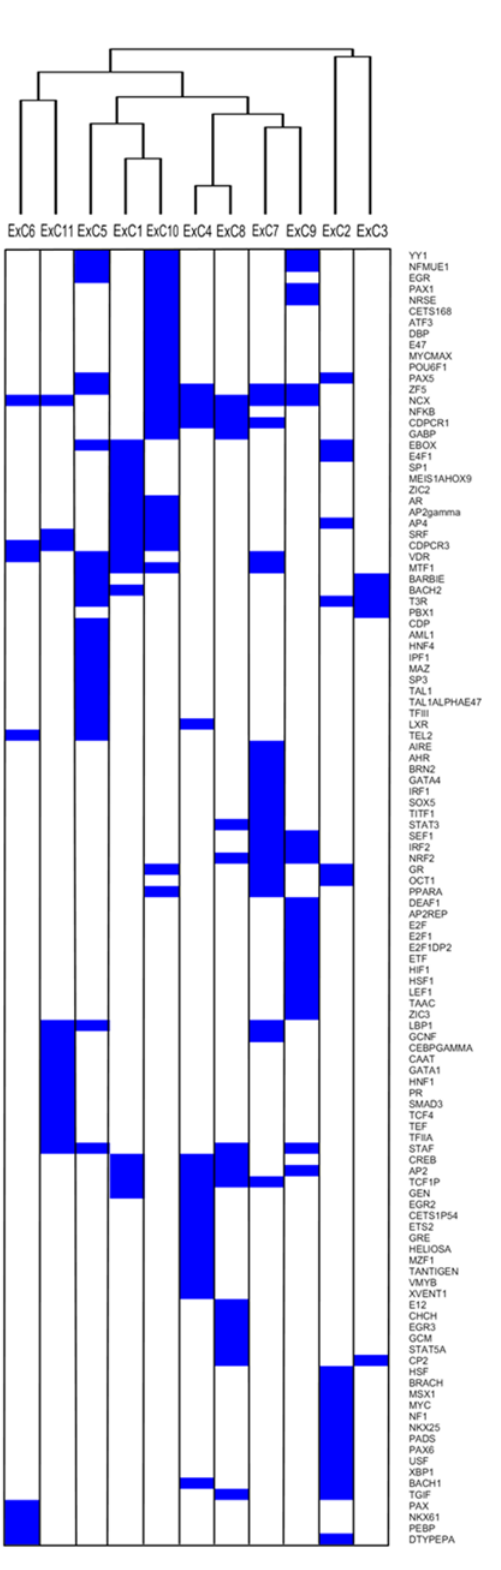
Figure 3. Cluster analysis of putative transcription factor binding sites for each expression cluster. The figure shows potential binding site motifs for cis -acting regulatory factors in sequences 2 Kb upstream and 0.5 Kb downstream of transcripts in each expression cluster. Blue boxes indicate the significant presence of a putative binding site, with the TRANSFAC identifier to the right of the figure. Binding sites (rows) and expression clusters (columns) are